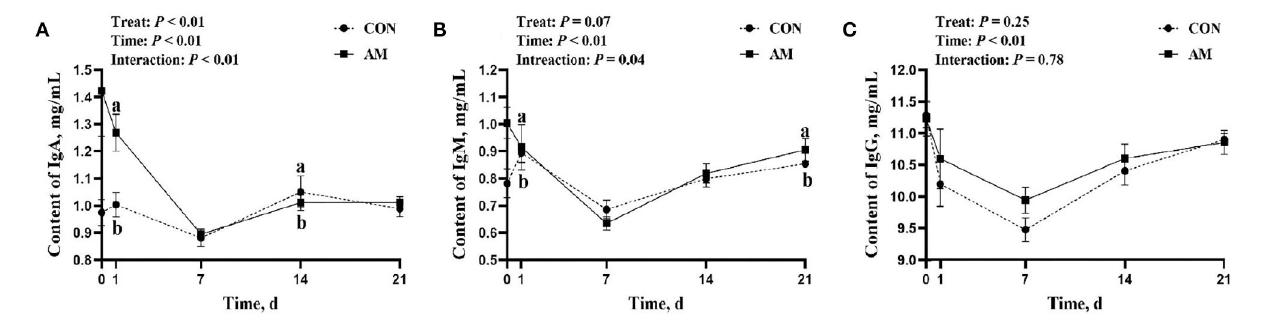
cows experience during postpartum period. A cow in the better physical condition is always more resistant to risks than a cow in poor physical